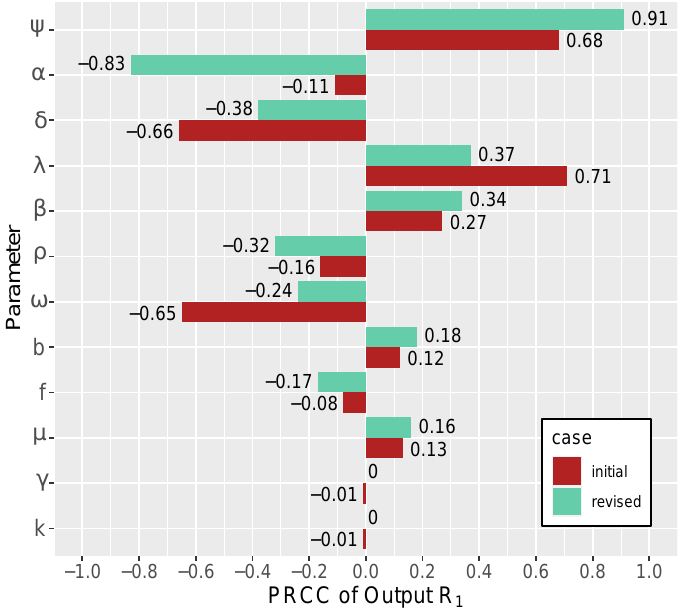
Figure 7. Tornado plot of the PRCC values for each parameter for initial min and max ranges (red/bottom bars for each parameter) and revised lower and upper ranges (green/top bars for each parameter) using values from Table 1. Note the increased trends from ψ and α using the revised ranges, whereas δ , λ and ω lose significance close to the